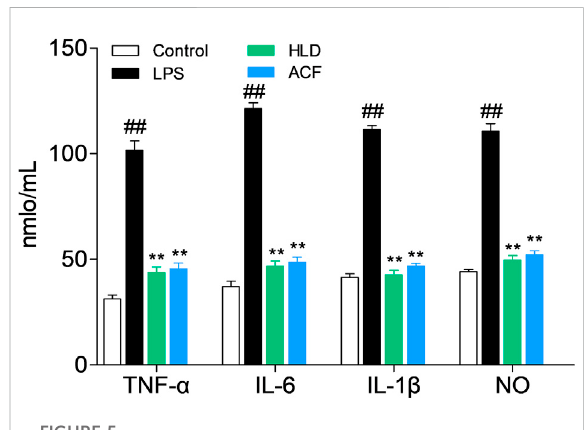
FIGURE 5 EffectofACFoncytokines(NO,IL-1 β ,IL-6,andTNF- α )inrats.